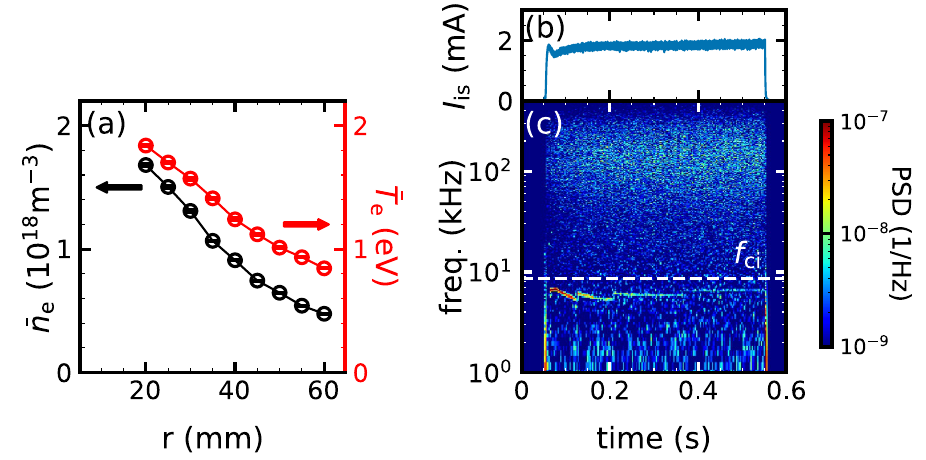
Figure 1. ( a ) Radial profiles of electron density (black) and electron temperature (red). Time evolution of ( b ) ion saturation current and ( c ) frequency spectrum. White dashed line in ( c ) indicates ion cyclotron